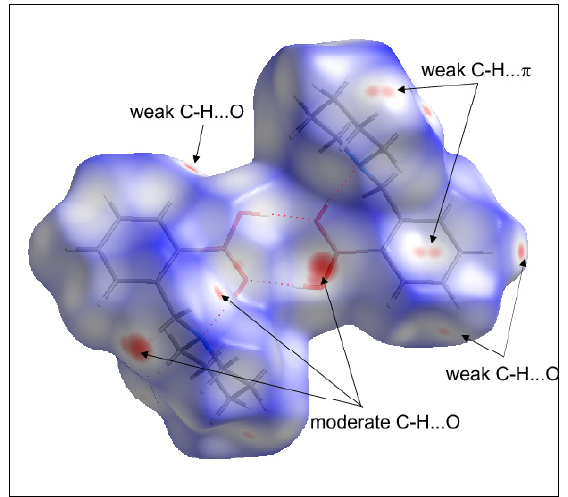
Hirshfeld surface of O–H…O bonded 3a dimer mapped with d . The O–H…O and O–H…N hydrogen bonds norm within the surface are shown as a dashed lined. The red spots on the surface indicate the presence of weaker intermolecular interactions.